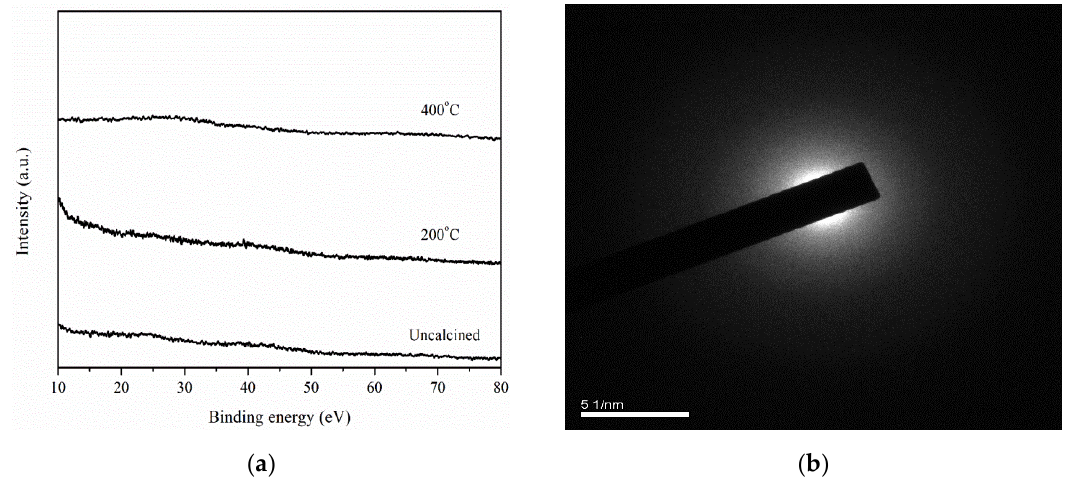
Figure 2. ( a ) XRD data of Ba 0.5 AlO x under different calcining temperatures and ( b ) TEM image of uncalcined Ba 0.5 AlO x .